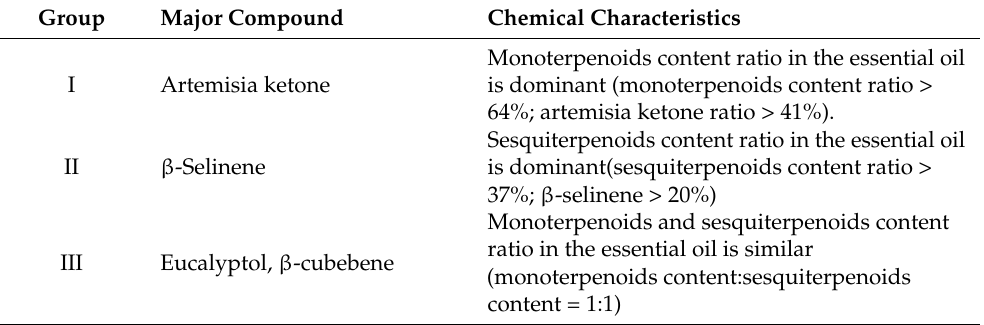
Figure 3. Dendrogram shows three groups of 103 A. annua individuals based on their essential oil components. Table 3. Characteristics of chemical composition for three different clusters of A. annua individuals from